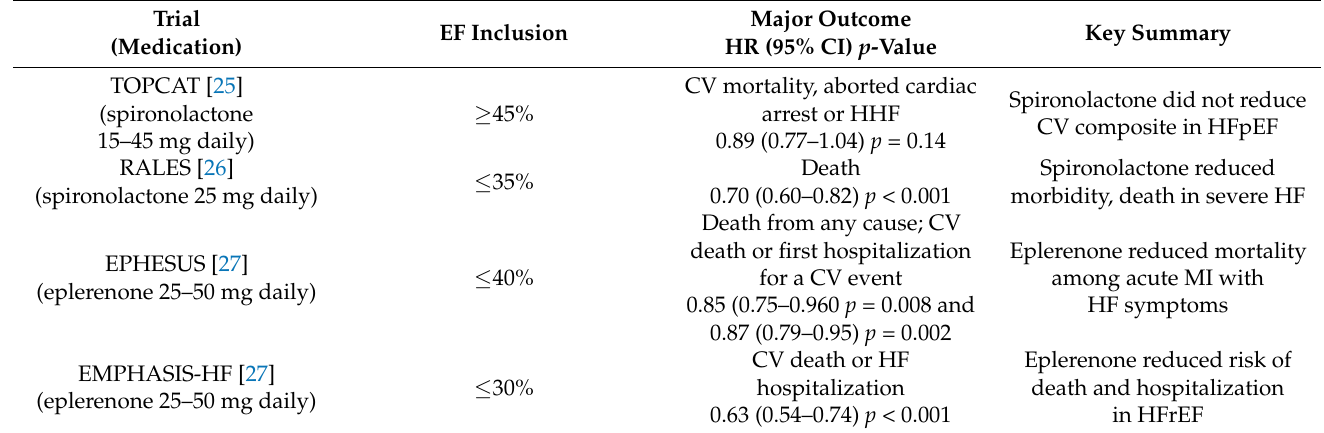
Table 5. Mineralocorticoid receptor antagonist heart failure